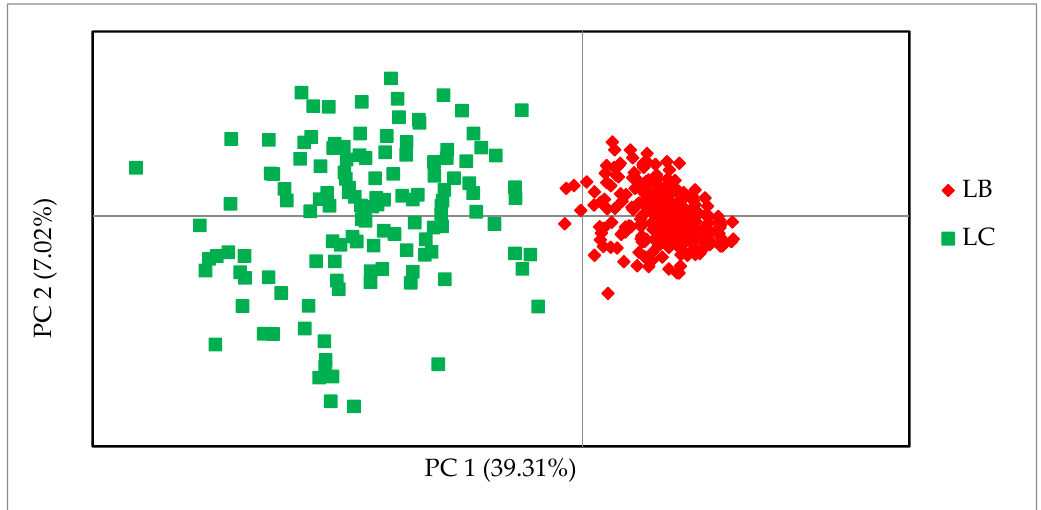
Figure 2. Principal Coordinates Analysis (PCoA) based on 30 SNPs. LB—Lowland line and LC— Lowland–Caucasian line.